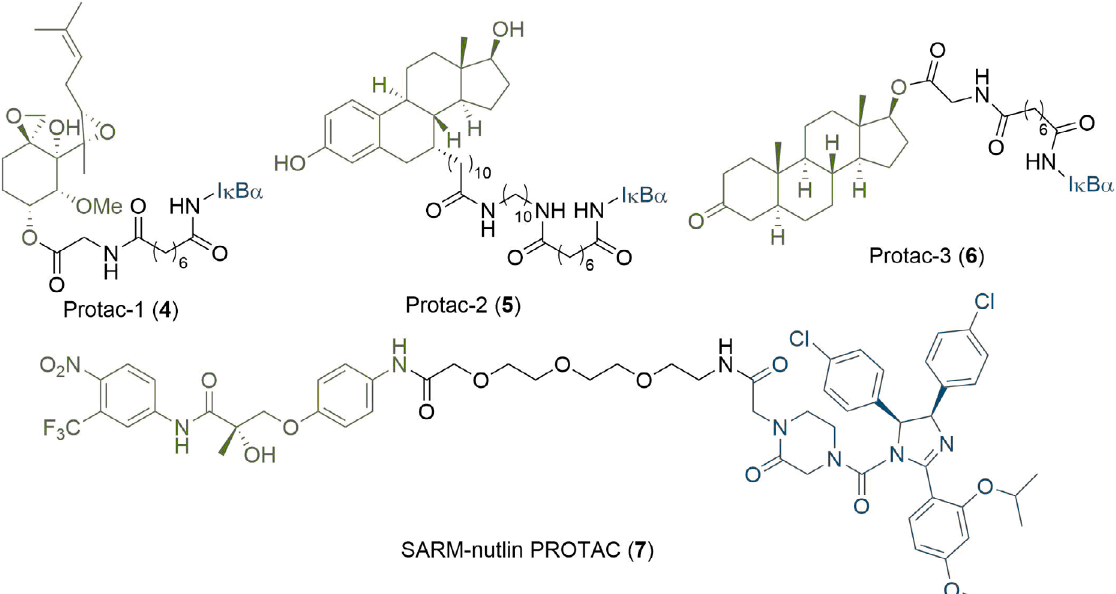
Figure 3. Early PROTAC development: the first published PROTAC degrader (4), which conjugates the angiogenesis inhibitor ovalicin to the IκBα phosphopeptide (denoted IκBα); structures of second generation PROTACs targeting the ER (5) and AR (6) receptors; the first all small-molecule PROTAC incorporating the MDM2 ligand nutlin-3 (7). In all PROTACs, the anchor is coloured blue and the warhead